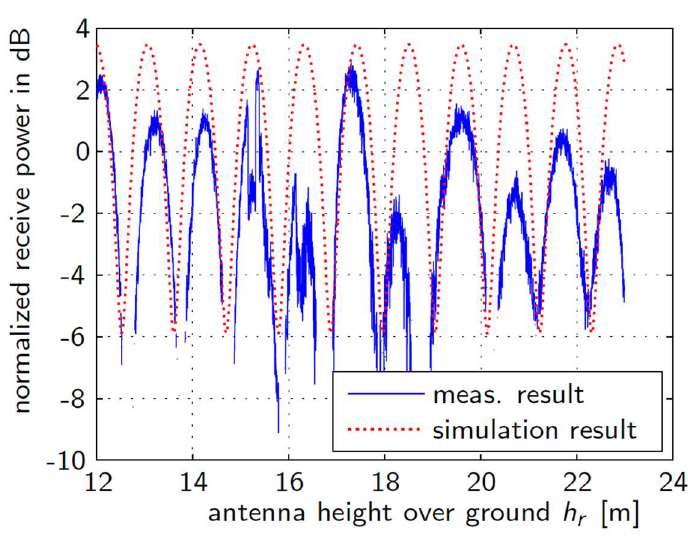
Figure 14. ICARUS Multipath Propagation Scenario.